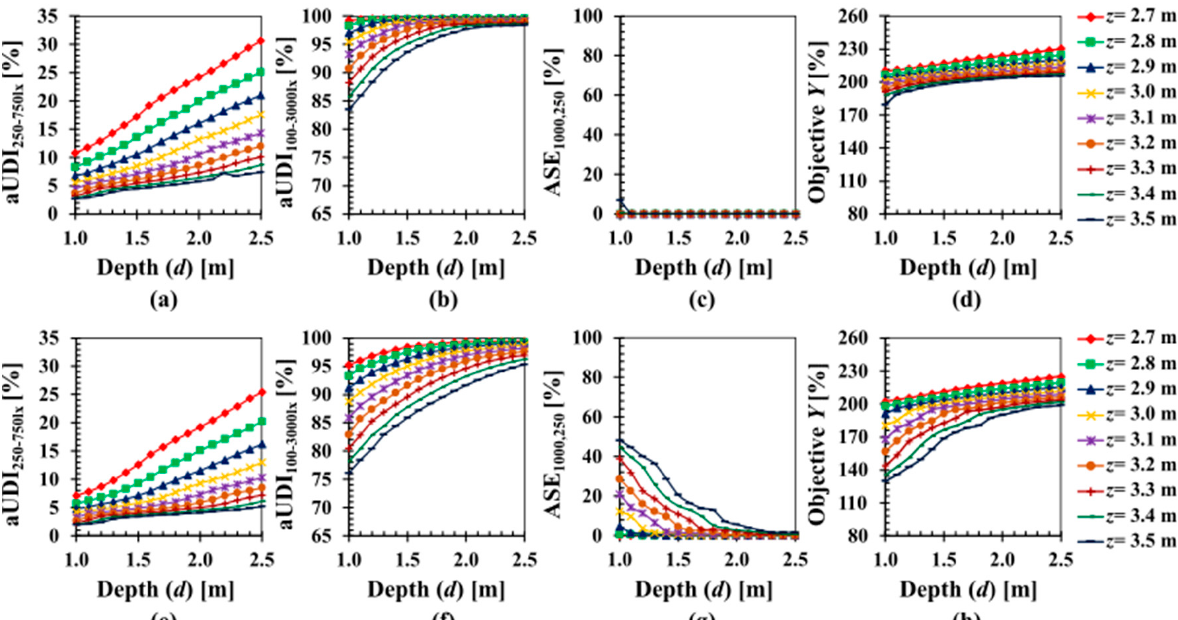
Figure 7. Simulation results at orientation of 90° for metrics ( a ) aUDI 250–750lx , ( b ) aUDI 100–3000lx , ( c ) ASE 1000,250 , and ( d ) objective function Y; and at orientation 135° for metrics ( e ) aUDI 250–750lx , ( f ) aUDI 100–3000lx , ( g ) ASE 1000,250 , and ( h ) objective function Y.